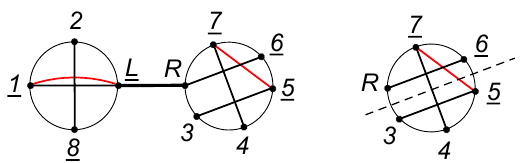
Figure 14 . A new gauge fixing and its factorization